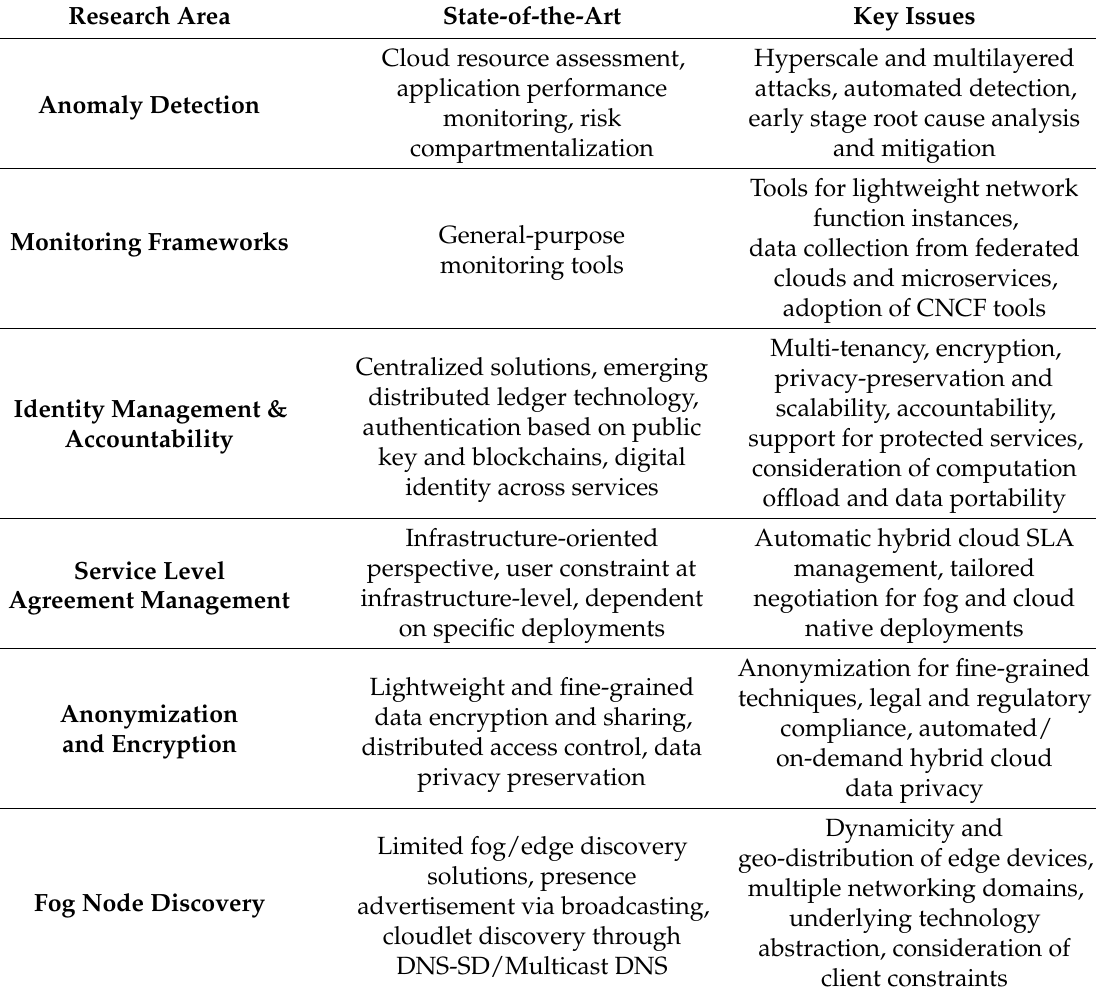
Table 1. Relevant research areas for hybrid clouds with their current advances and key